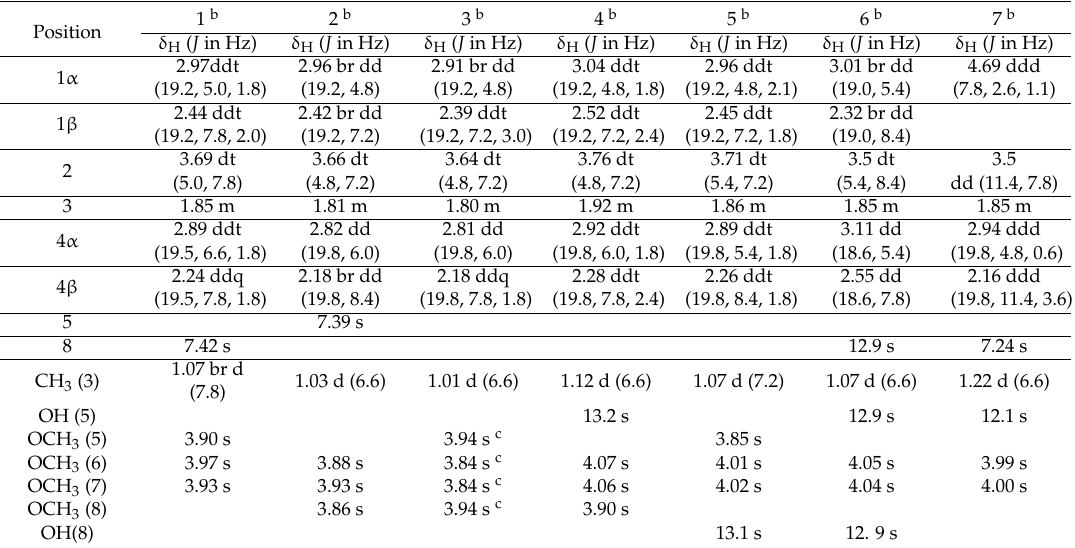
Table 2. 1 H-NMR Data for prisconnatanones C ´ I ( 1 ´ 7 ) a